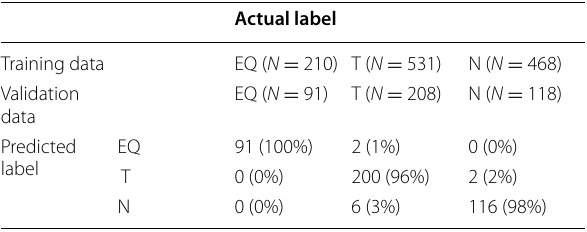
Table 1 Matrix for the training and validation data of EQ–T–N